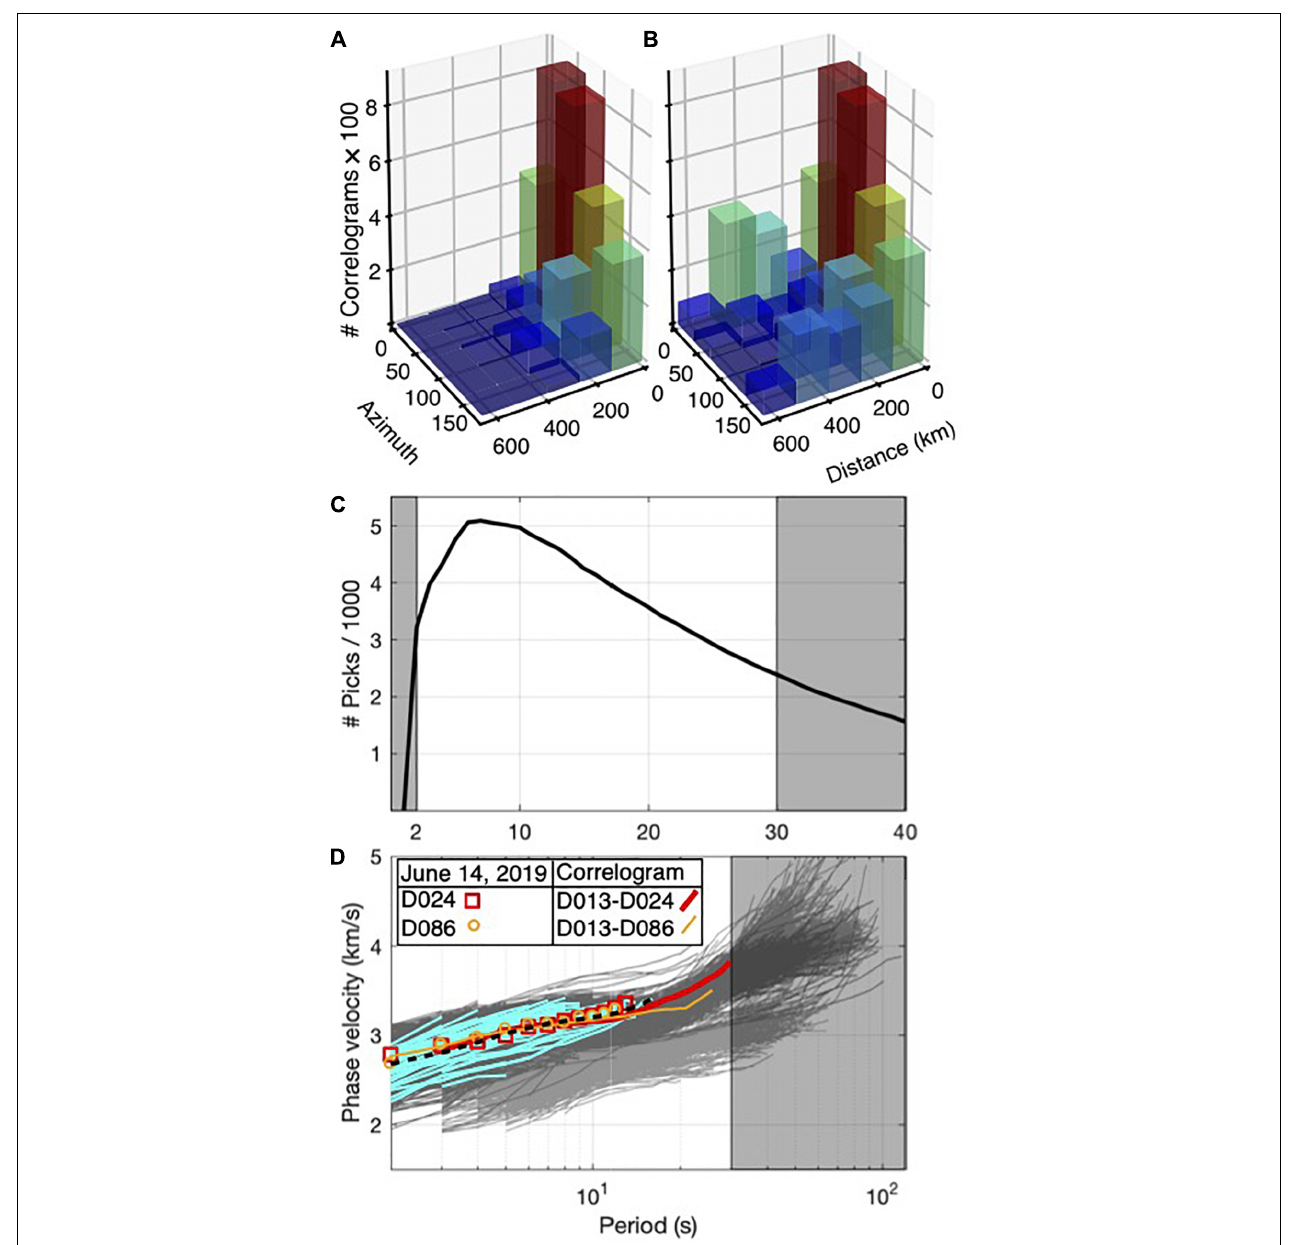
FIGURE 3 | (A) Number of correlograms calculated in this study vs. interstation distance and azimuth. (B) Number of correlograms used in this study, including the high quality correlograms of Nouibat et al. (2021), vs. interstation distance and azimuth. (C) Number of Rayleigh phase velocity picks at different periods. (D) Phase velocity dispersion curves measured from correlograms calculated in this study (dark gray) superimposed on the dispersion curves measured from correlograms adopted from Nouibat et al. (2021) (lighter gray). The phase velocity dispersion curves from 44 records of the June 14, 2019, Mw 3.7 earthquake and the average curve are shown by cyan and black lines, respectively. The dispersion curves from D013-D024 and D013-D086 correlograms and those of the earthquake waveforms recorded by D024 and D086 stations are also shown. The horizontal axis label is shared in (C,D) . Gray boxes in (C,D) show the periods excluded from